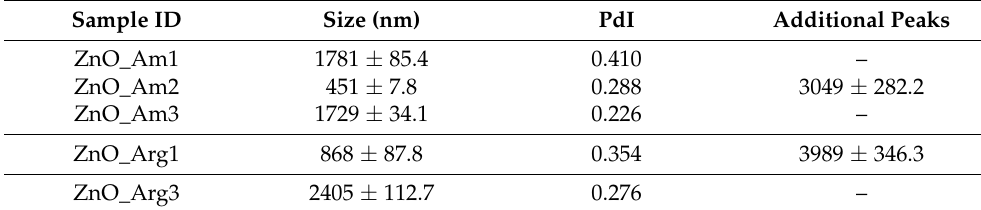
Table 2. Size and size distribution of ZnO NPs prepared under various conditions.